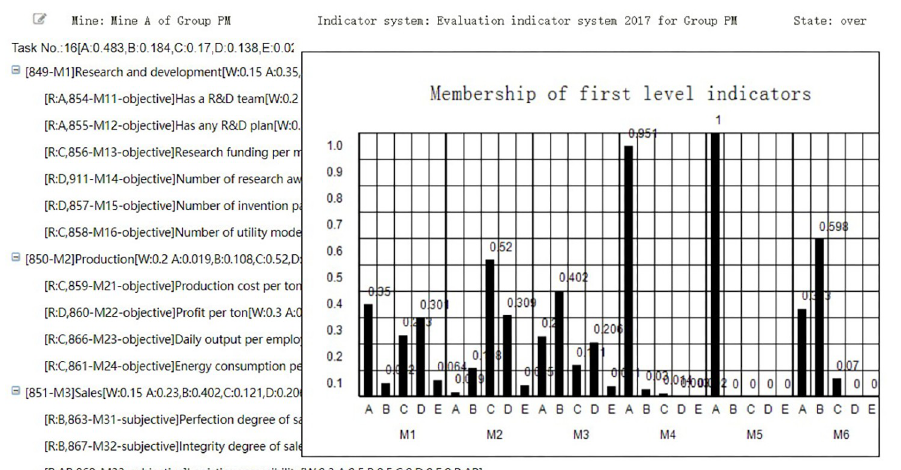
Fig 18. Membership evaluation